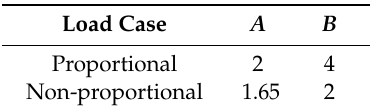
Table 5. Values of exponential parameters used in Equation